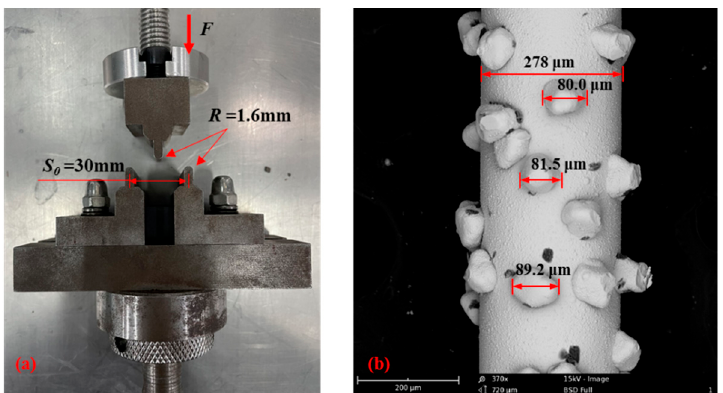
Figure 3. ( a ) Sample fixture for the three-point bending test, where F is the loading force, R is the radius of pressure head and bearing rollers, and S 0 is the span of three-point bending. ( b ) Diamond wire saw.